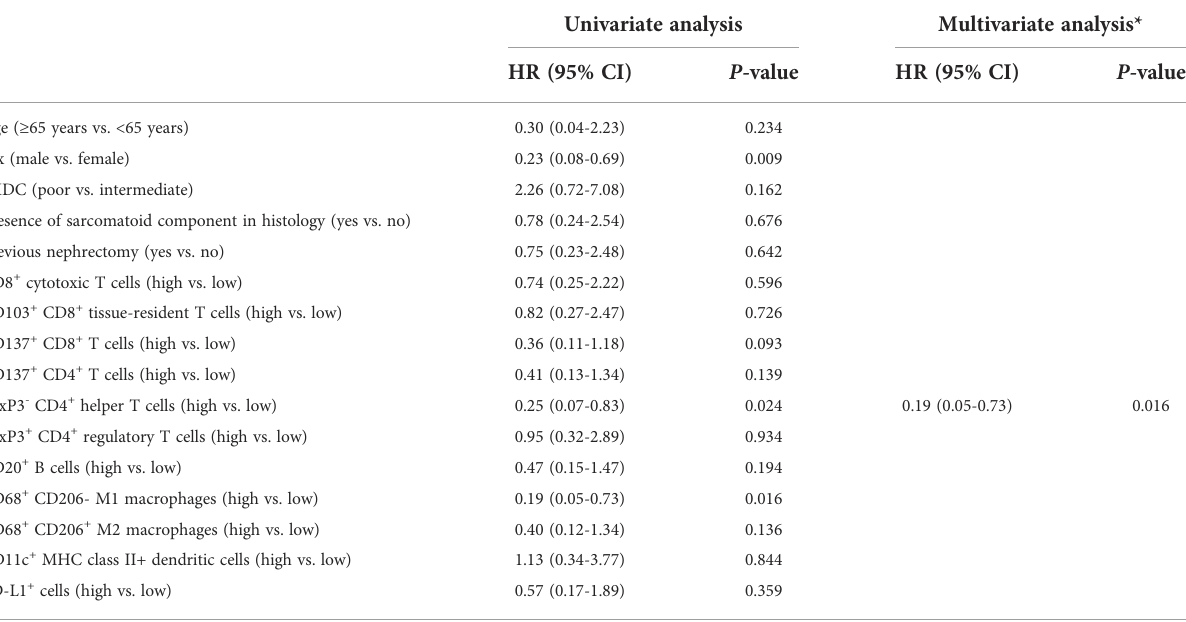
TABLE 3 Univariate and multivariate analysis for progression-free